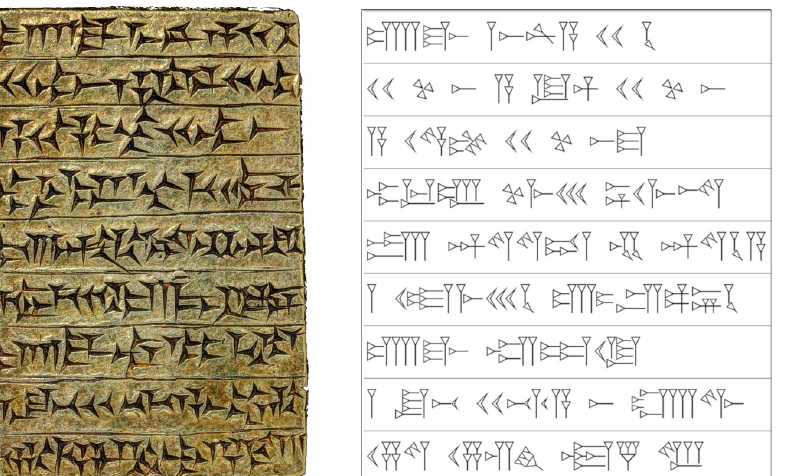
Fig 2. Example of Unicode cuneiform. On the left are the original cuneiform characters written on the obverse of the gold tablet introduced in Fig 1. On the right is the Unicode version which was generated from the transliteration of this